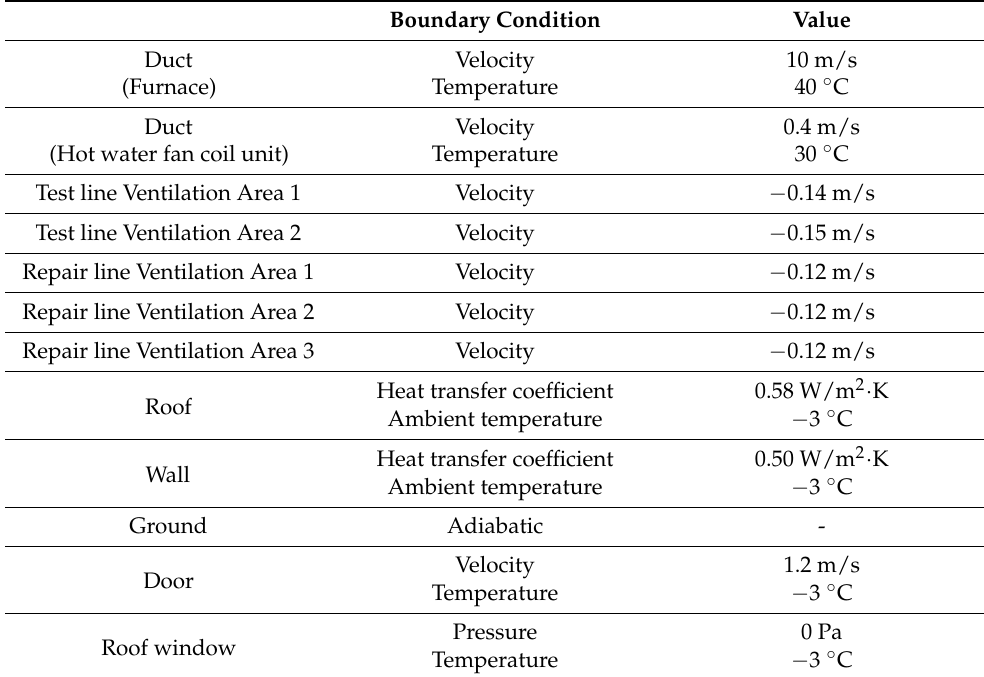
Table 2. Boundary condition of the computational domain.